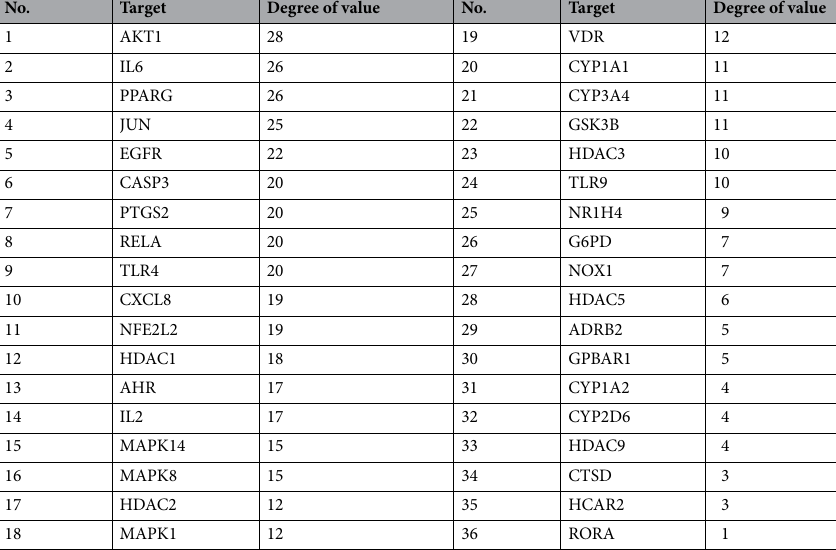
Table 1. The degree of value of PPI networks. HDAC5, histone deacetylase 5; ADRA2B, alpha-2B adrenergic receptor; HCAR2, hydroxycarboxylic acid receptor 2; ADRB2, adrenoceptor beta 2; HDAC3, histone deacetylase 3; HDAC2, histone deacetylase 2; HDAC1, histone deacetylase 1; CTSD, cathepsin D; IL2, interleukin 2; TLR4, toll-like receptor 4; TLR9, toll-like receptor 9; AKT1, AKT serine/threonine kinase 1; EGFR, epidermal growth factor receptor; CXCL8, C-X-C motif chemokine ligand 8; PTGS2, prostaglandin- endoperoxide synthase 2; MAPK8, mitogen-activated protein kinase 8; IL6, interleukin-6; JUN, jun proto- oncogene, AP-1 transcription factor subunit; GSK3B, glycogen synthase kinase-3 beta; RELA, RELA proto- oncogene, NF-KB subunit; MAPK14, mitogen-activated protein kinase 14; CASP3, caspase 3; MAPK1, mitogen-activated protein kinase